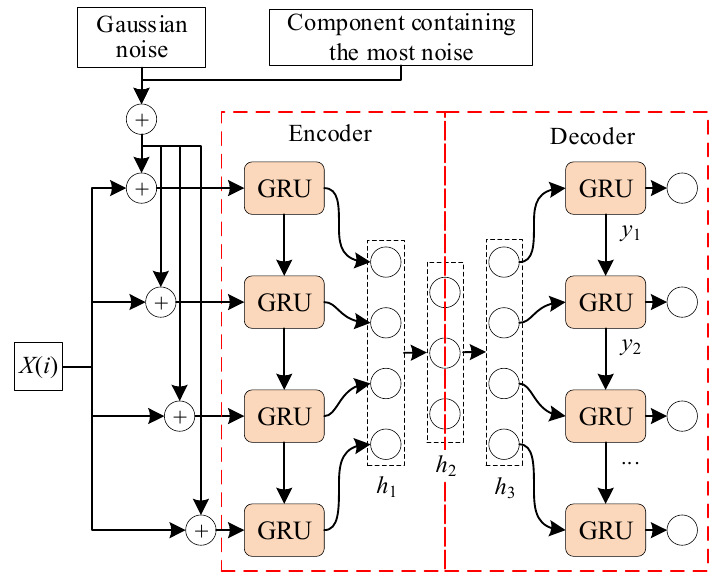
Figure 5. GAE Model.